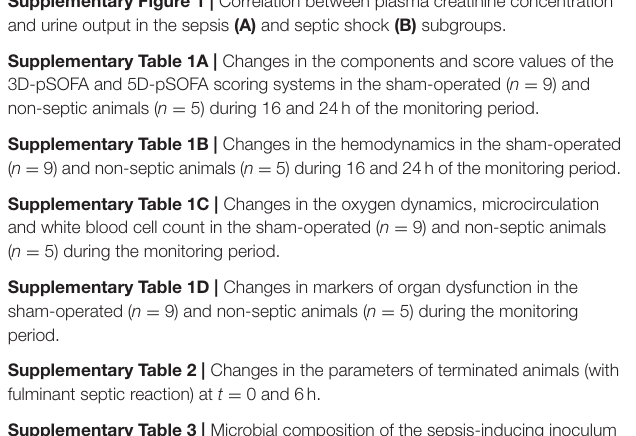
non-septic animals ( n = 5) during 16 and 24h of the monitoring period.